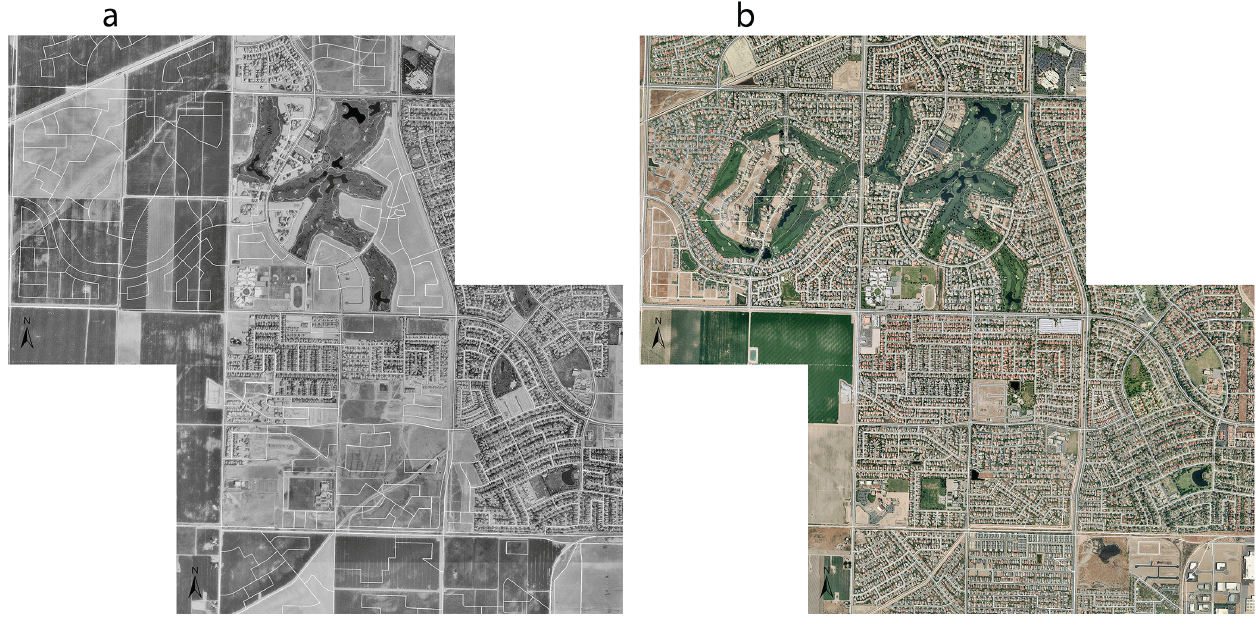
Fig. 5 . Time-series orthophotos of an example portion of the Bakersfield study area in (a) 1994 and (b) 2010. In this example, much of the area observed as developed in 2010 was in initial stages of development or still in agricultural use in 1994.